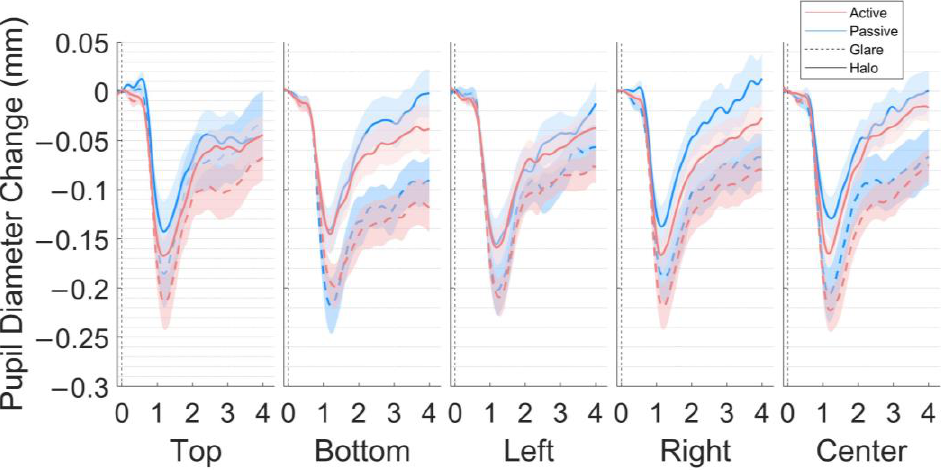
Figure 3. Pupil size changes in the five locations (top, bottom, left, right, and center) in the world- centered coordinates. The grand average of pupillary response to the glare illusion and halo stimulus (millimeters) during the 4-s stimulus presentation for 18 participants after subtractive baseline correction in the active and passive scenes. The dotted line represents the baseline period ( − 0.2 s).